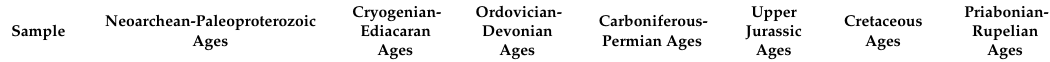
Table 2. The U-Pb zircon concordant ages in millions of years (Ma) measured in each sample. The ages in italic font are sub-concordant with % U-Pb discordance ranging from 12% to 27%. The ages > 1.4 Ga in the TTB sample derived from the 206 Pb / 207 Pb